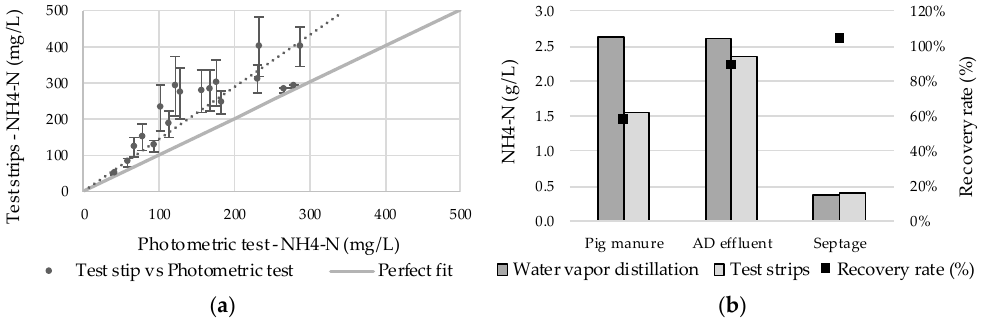
Figure 5. Ammonium–nitrogen (NH 4 -N) determination: comparison of test strips with ( a ) photometric tests with watery samples and ( b ) water-vapor distillation with sludges.